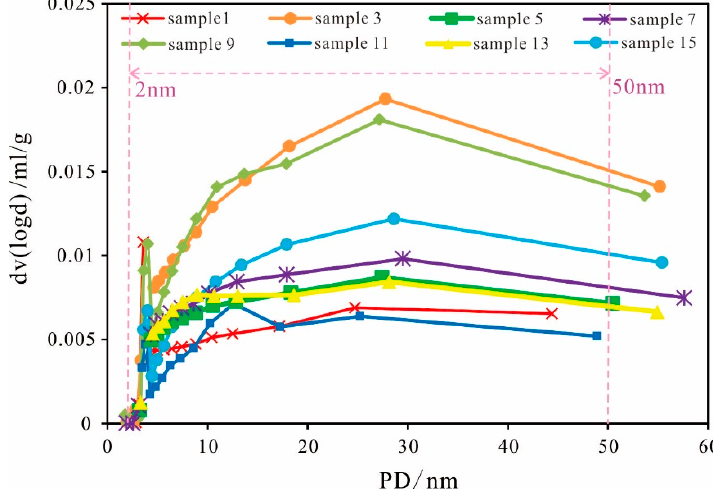
Figure 6. Pore size distribution of some shale samples.